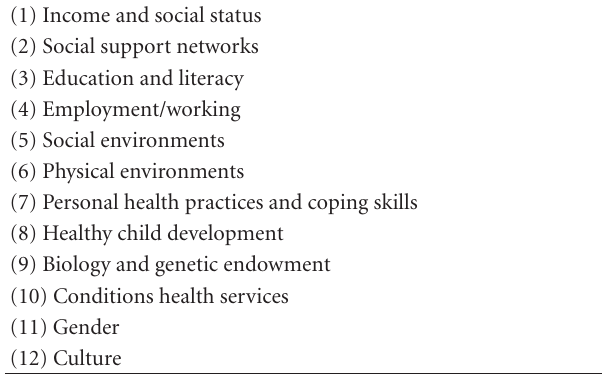
Table 1: The twelve determinants of